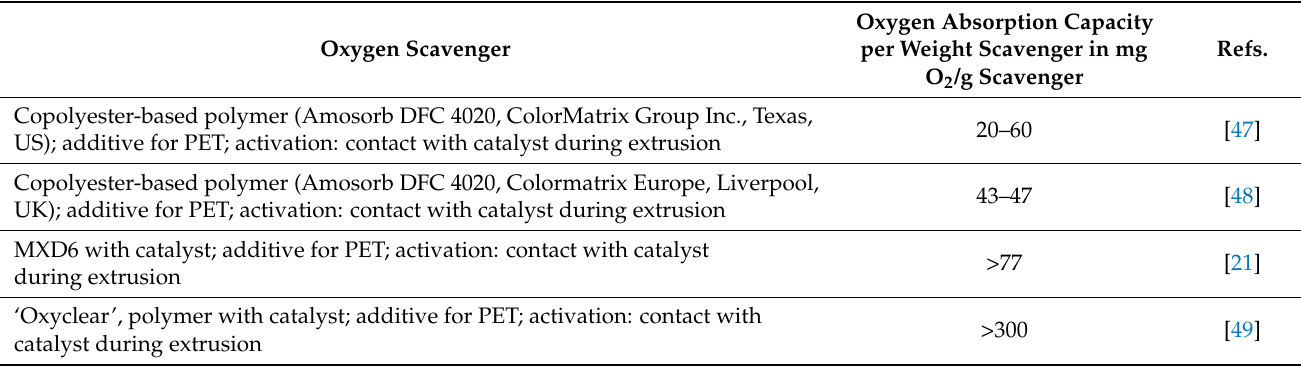
Oxygen Scavenger